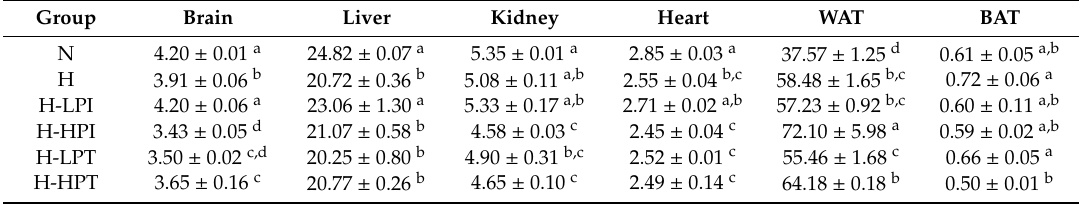
Table 3. E ff ects of inhalation of PEO on organ and tissue weights (g /